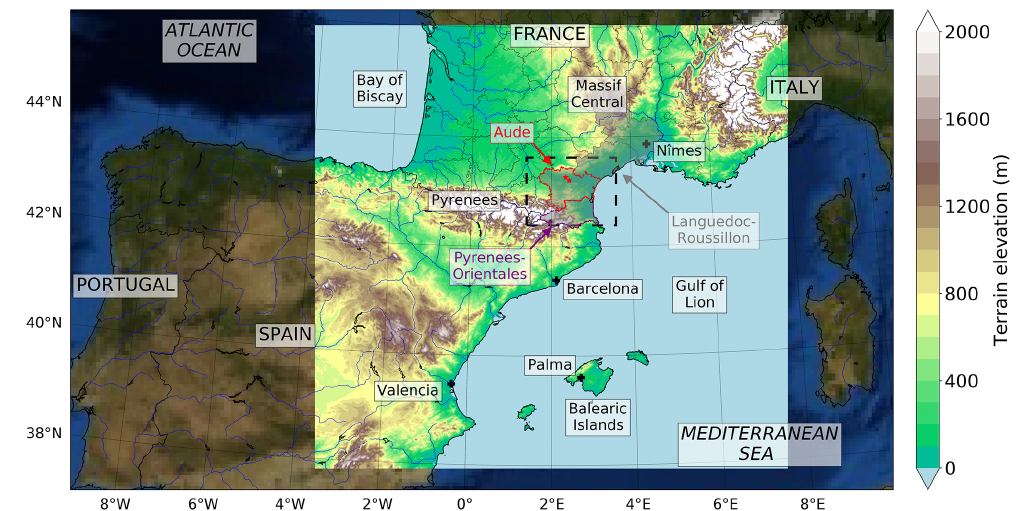
Figure 1. Map of south-western Europe. The bright square and the dashed black line correspond to the two grid-nested model domains. Inside the bright square, terrain elevation from the parent model is shown; outside, it is the NASA visible blue marble image (from https: //visibleearth.nasa.gov, last access: 20 July 2021). Solid black lines indicate French departments and country borders. Languedoc-Roussillon, a region including Aude and Pyrenees-Orientales departments, is shaded. The two little red stars, landmarks displayed in other figures, indicate from north to south the locations of Villegailhenc and Trèbes, which are two towns that were affected by the HPE.